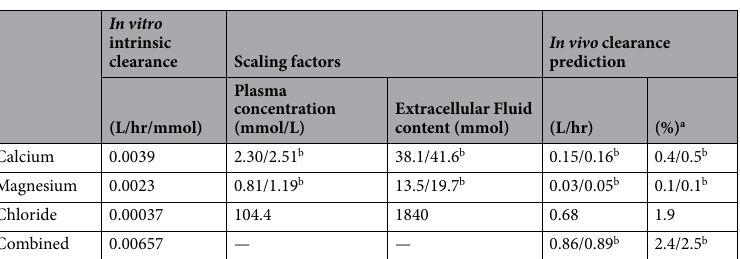
Table 3. In vitro prediction of effects of calcium-, magnesium- and chloride-mediated oxaliplatin degradation on the in vivo clearance of oxaliplatin. a Percentage of measured in vivo oxaliplatin clearance (35.3 L/hr); b Before/ after CaGluc/MgSO 4